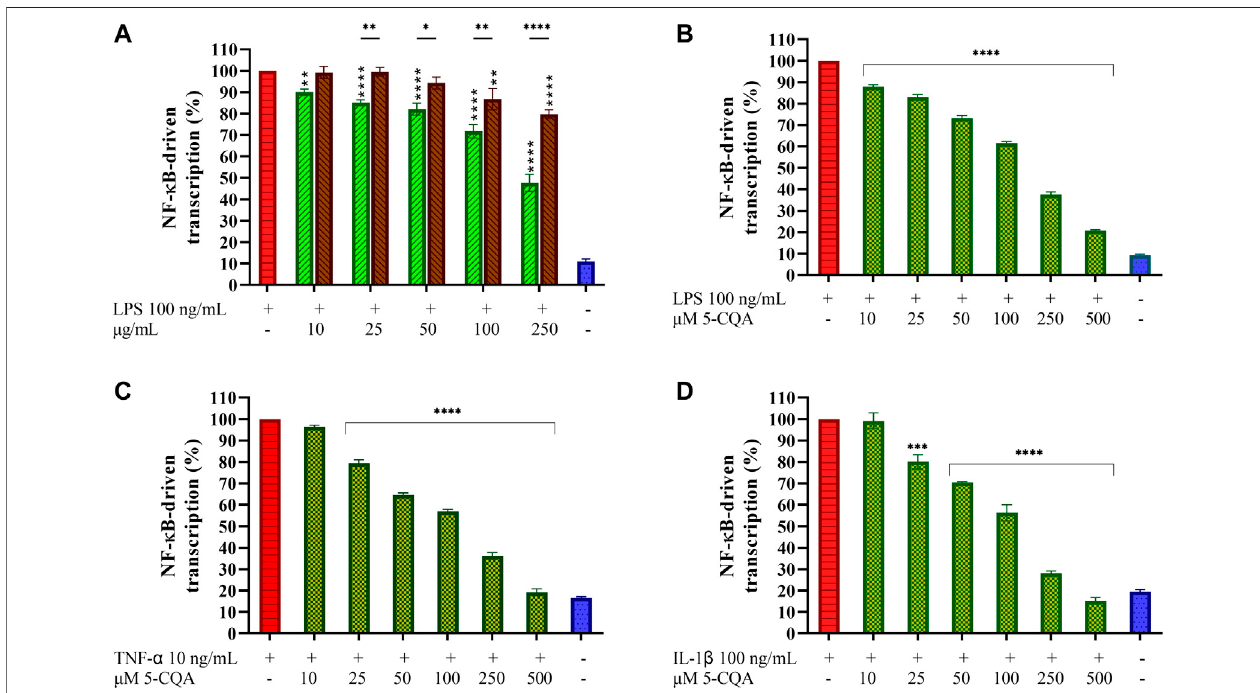
FIGURE 5 | Effect ofCoffeeExtractsand 5-CQA on NF- κ B-dependent transcription inTHP1-XBlue ™ -derived macrophages. (A) THP-1-derived macrophages (TDM) cellstreatedwithincreasingconcentrationsofGCE(green,down-updiagonalpattern)andRCE(brown,up-downdiagonalpattern)for1 handthenchallengedwith100 ng/ mlLPS. (B) TDM cellspre-treatedwithincreasing concentrationsof5-CQA(dark green,squarepattern)for1 hand thenchallengedwith100 ng/mlLPS. (C) TDM cells pre- treatedwithincreasingconcentrationsof5-CQA(darkgreen,squarepattern)for1 handthenchallengedwith10 ng/mlTNF- α . (D) TDMcellspre-treatedwithincreasing concentrations of 5-CQA (dark green, square pattern) for 1 h and then challenged with 100 ng/ml IL-1 β . Activation of the NF- κ B pathway was assessed by using THP1- XBlue ™ cells as a reporter cell line and quantifying the activity of SEAP released in the medium after 18 h. Results refer to positive control (100%). Data are represented as mean±SEMofthreeindependentexperiments( n =3).Resultsarereferredtountreatedcontrol(100%)(one-wayANOVA,* p < 0.05,** p < 0.01,*** p < 0.001,**** p <